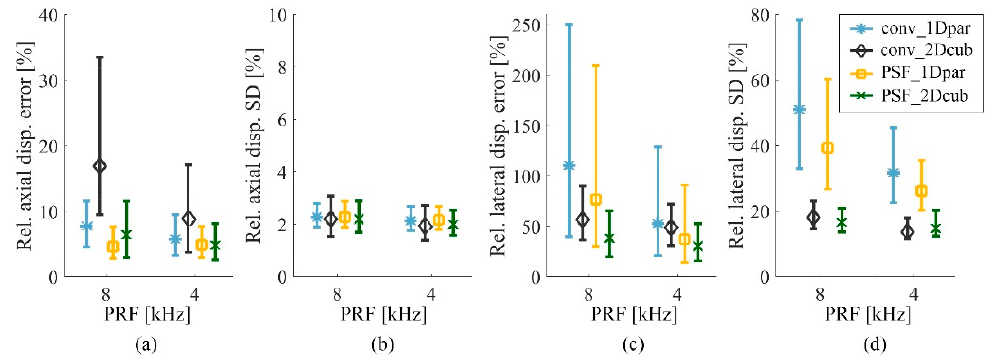
Figure 10. Median and interquartile ranges of the absolute bias and SD for the axial ( a , b ) and lateral ( c , d ) inter-frame displacements obtained from the rotating disk setup processed as rotational vessel wall displacements. The performance of the methods is visualized as function of the PRF, which corresponds to a range of inter-frame displacement (Table 2).